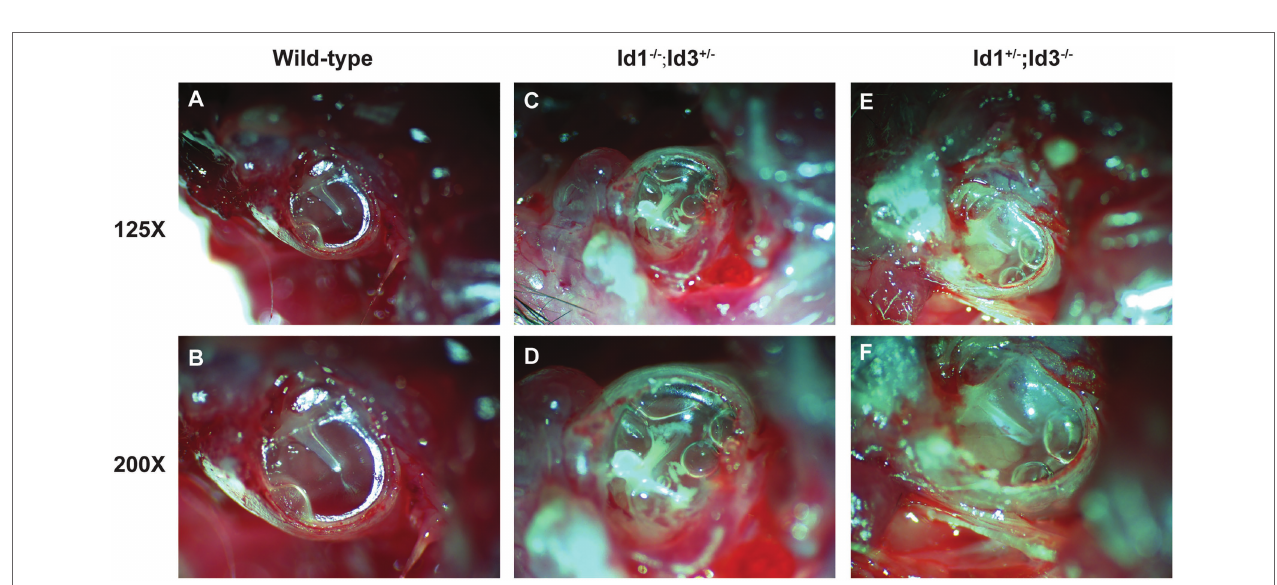
FIGURE 3 | Comparison of the distortion product of otoacoustic emission (DPOAE) amplitudes of right ears from age-matched littermate control mice, Id1 − / − ; Id3 +/ − and Id1 +/ − ; Id3 − / − mice at ages P30 and P60. The results indicated that at P30, the DPOAE amplitudes of Id1 − / − ; Id3 +/ − ( n = 12) and Id1 +/ − ; Id3 − / − mice ( n = 9) were significantly lower than those of the control mice ( n = 13) at dominant frequencies. At P60, the DPOAE amplitudes at dominant frequencies in the Id1 − / − ; Id3 +/ − mice ( n = 35) were significantly lower than those of the controls ( n = 8), and the DPOAE amplitudes at two frequencies in Id1 +/ − ; Id3 − / − mice were significantly lower than those of the controls ( n = 14). The error bar indicates SD from the mean or each group. * p < 0.05; ** p < 0.01.